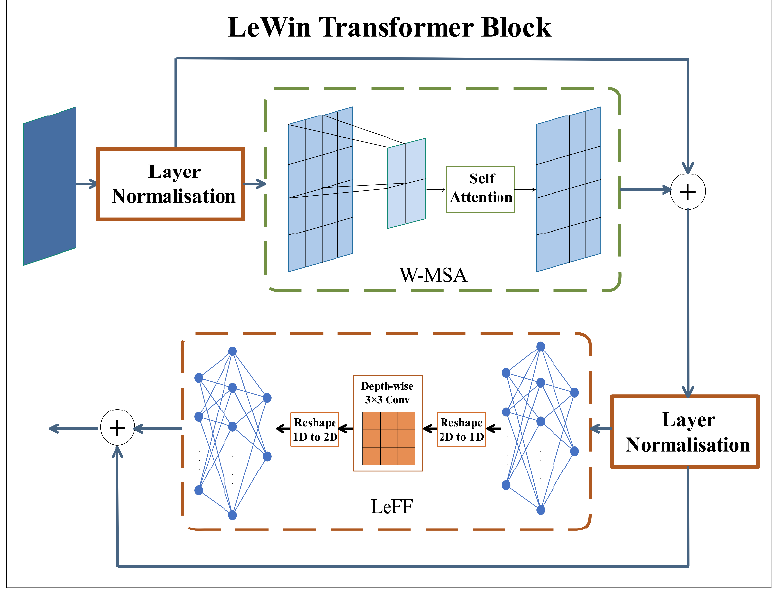
Figure 4. LeWin Transformer Block structure diagram.